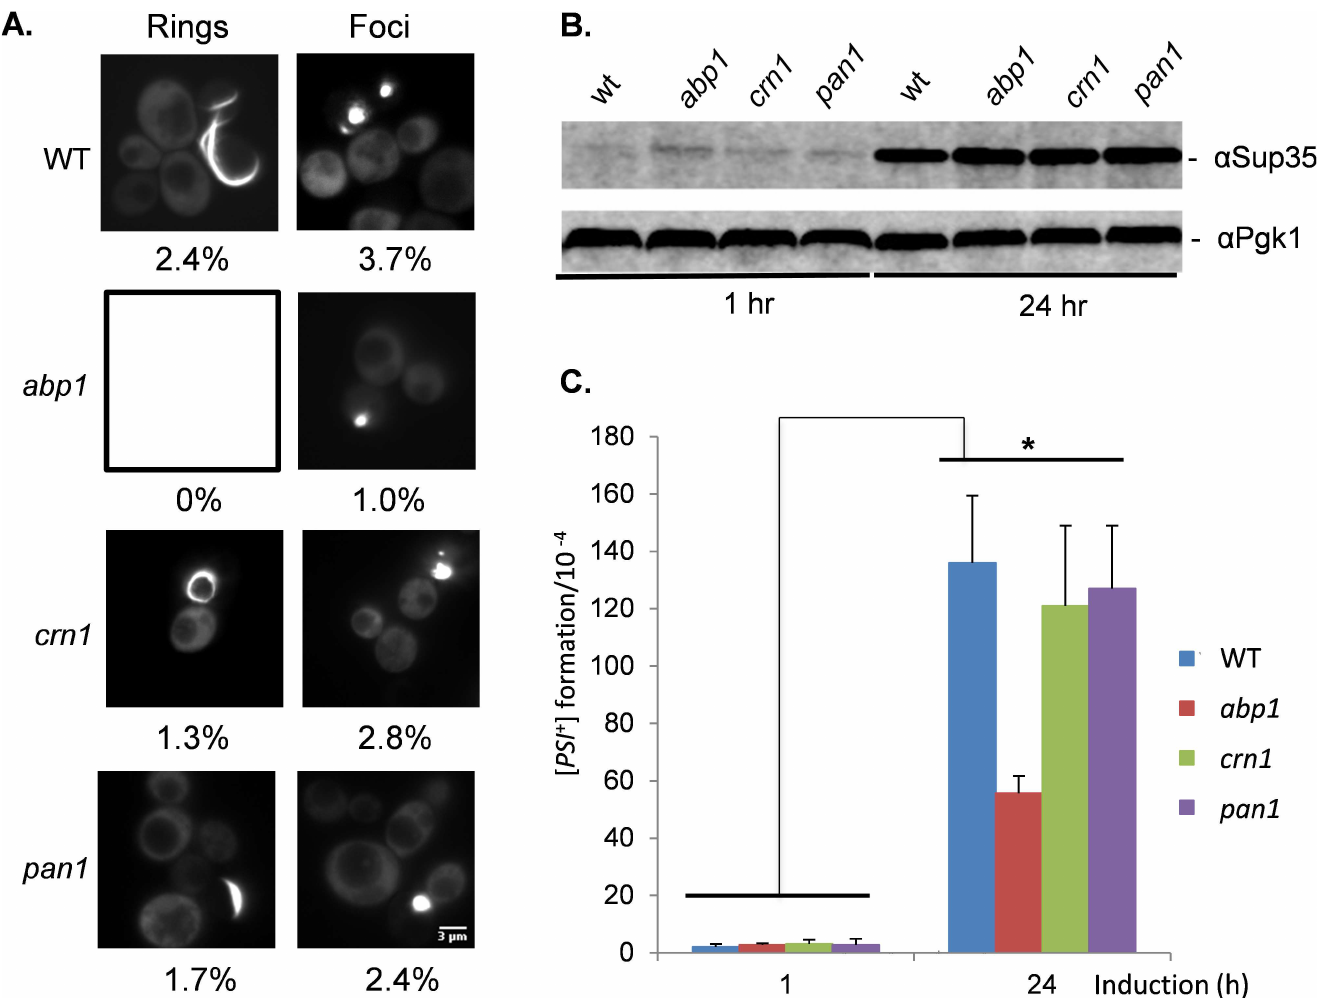
Fig 3. Induction of [ PSI + ] prion formation by overexpression of Sup35. A. Fluorescence micrographs are shown for [ PIN + ][ psi - ] versions of wild-type, abp1 , crn1 and pan1 mutant strains containingthe Sup35NM-GFP plasmidinducedwith copperfor 24 hours. Representative Images are shownfor rod/ ribbon-like and foci aggregate formation.The numbers indicatethe percentage of cells containingeach type of aggregatefrom an averageof 300 cells counted.The scale bar is 3 μ m. B. Western blot analysisof the wild-typeand abp1 mutant strain followinginductionof Sup35NM-GFP. Blots were probed with α Sup35or α -Pgk1as a loadingcontrol (C) [ PSI + ] prion formationwas quantifiedin the wild-typeand abp1 mutant strain containingthe Sup35NM-GFP plasmidfollowing24 h of copper induction. Data shown are the means of three independent biologicalrepeat experiments expressed as the number of colonies per 10 4 viablecells. Error bars denote standard deviation; * marks statistical significance at p < 0.01.